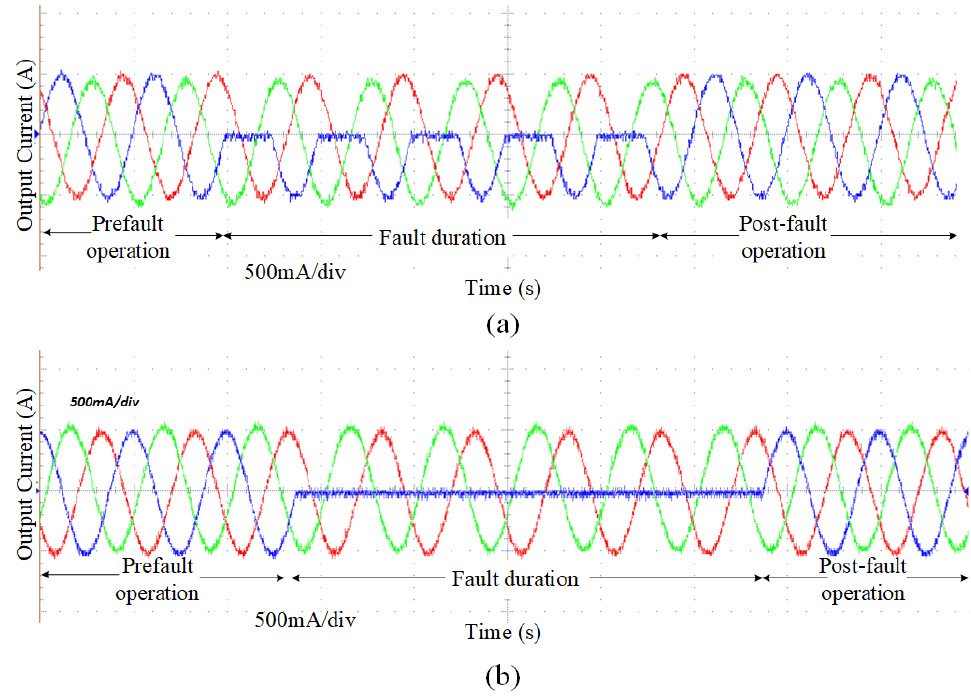
Figure 13. Experimental results under pre-fault, faulty, and post-fault operation ( a ) single-switch failure, and ( b ) two-switch failure.